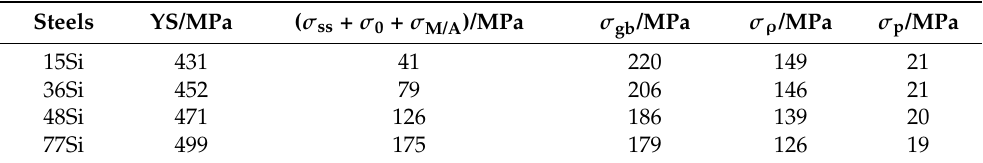
Table 4. Contributions of grain boundary strengthening, dislocation strengthening, and precipitation